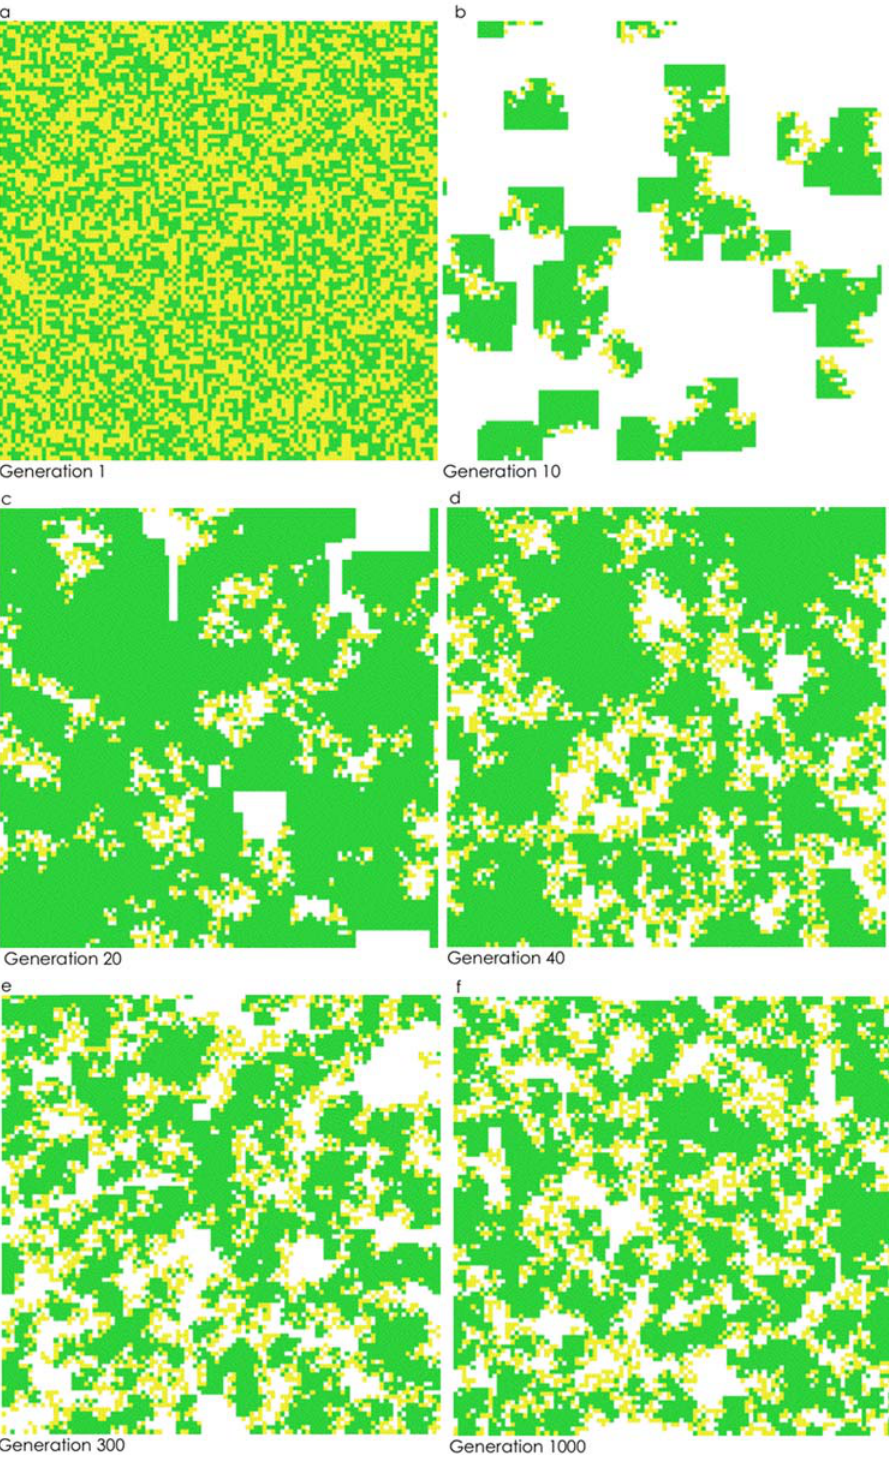
Figure 2. Two-dimensional snapshots of the 10,000 slot torus. B/C=0.56, help=0.19. a ) Generation 1, b ) Generation 10, c ) Generation 20, d ) Generation 40, e ) Generation 300 and f ) Generation 1000. Note that for generations 1–999, any yellow (nonproducers) cells surrounded by only yellow or by only yellow and white cells would die and be replaced the next generation. doi:10.1371/journal.pone.0002763.g002 We used NetLogo simulation software [23] to build an agent- with 10,000 ‘‘slots’’ was created, and we assumed that an based model for the evolution of antibiotic resistance when antibiotic, such as ampicillin, was present at all times during our producers and nonproducers interact. A 100 6 100 torus (no edges) simulations. At the start of a simulation, each slot held either a